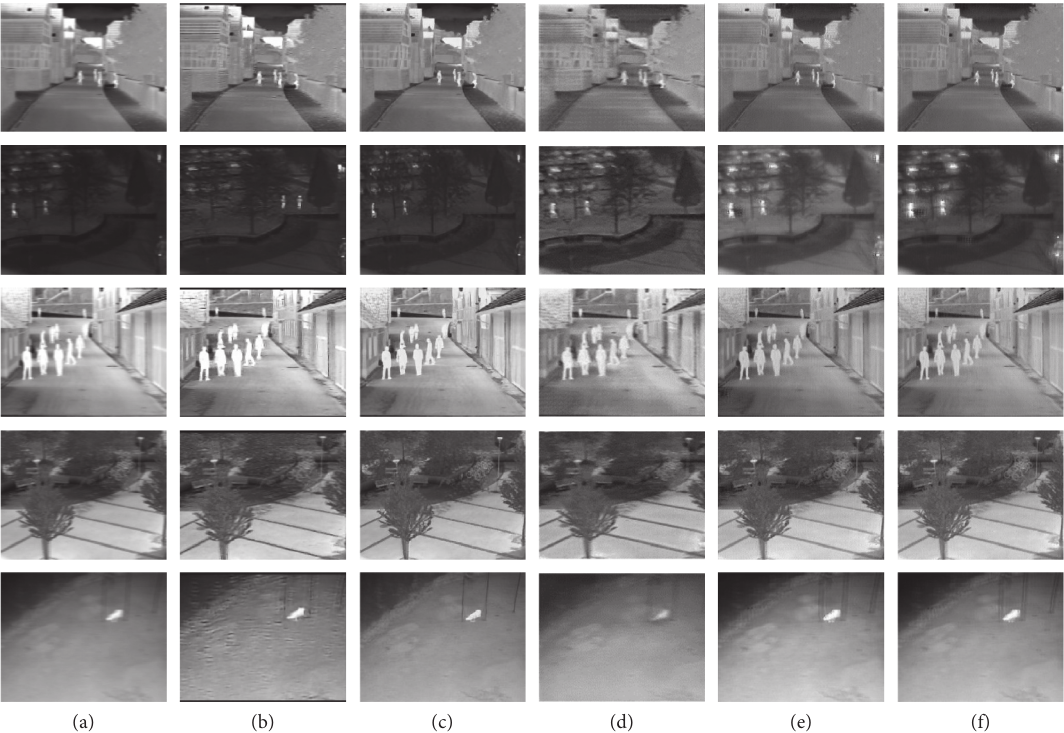
Figure 8: Deblurring results of the LTIR dataset. The columns from left to right are the original blurred image, the results of Schuler et al. [39], Kupyn et al. [36], Zhu et al. [51], Engin et al. [64], and the results of the proposed method in this article. (a) Blurred image. (b) DeepDeblur. (c) DeblurGAN. (d) CycleGAN. (e) Cycle-Dehaze. (f) Ours.